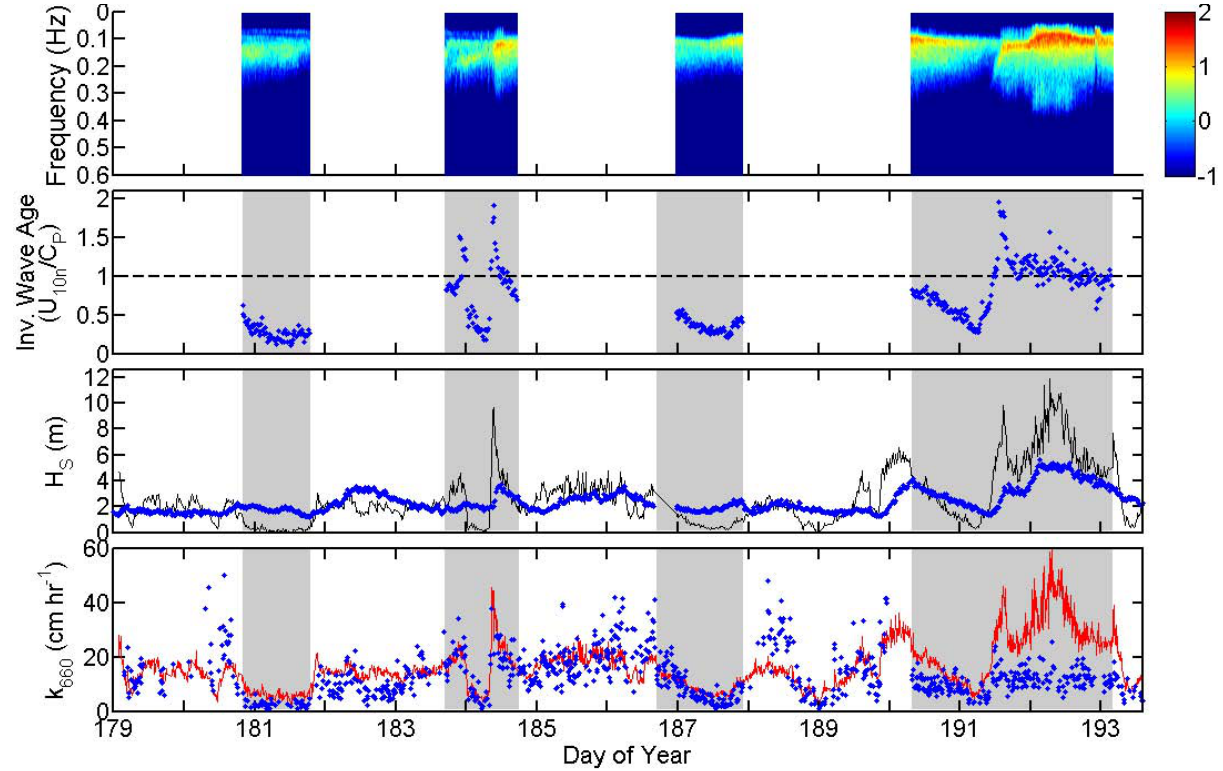
Fig. 6. Wave properties measured during Knorr_11. From top: (a) wave spectra (data only reported on station); (b) inverse wave age defined as U 10 n /C p ; (c) significant wave height ( H S , blue dots), and the Alves et al. (2003) empirical parameterization of H S for fully developed seas: H S = 0 . 025 · U 2 . 01 (black line); and (d) gas transfer coefficient for DMS (as k 660 , blue dots) with NOAA COARE DMS model (red 10 n